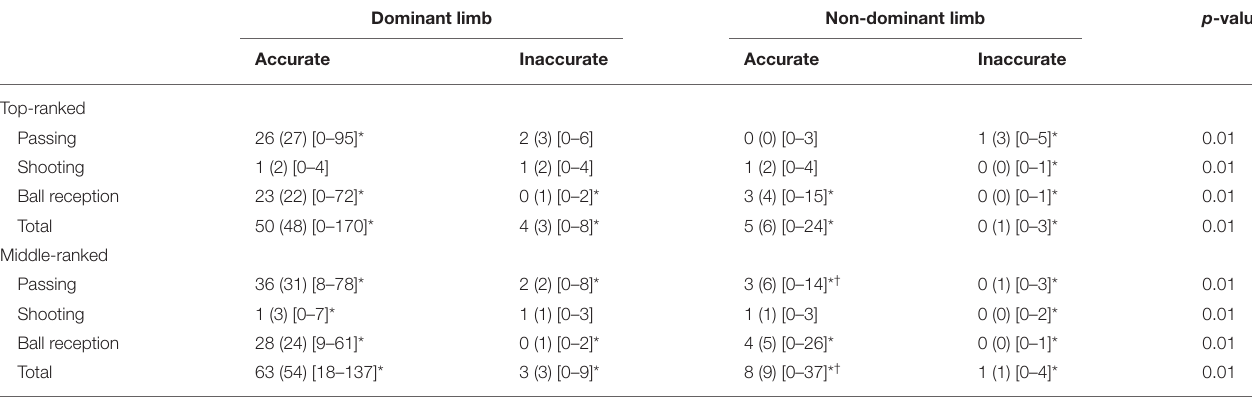
TABLE 4 | Median, interquartile range, and extreme values regarding the frequency counts (i.e., absolute number; a.u.) of technical parameters using dominant and non-dominant limb, computed according to the level of opponent. Dominant limb Non-dominant limb p -value Accurate Inaccurate Accurate Inaccurate